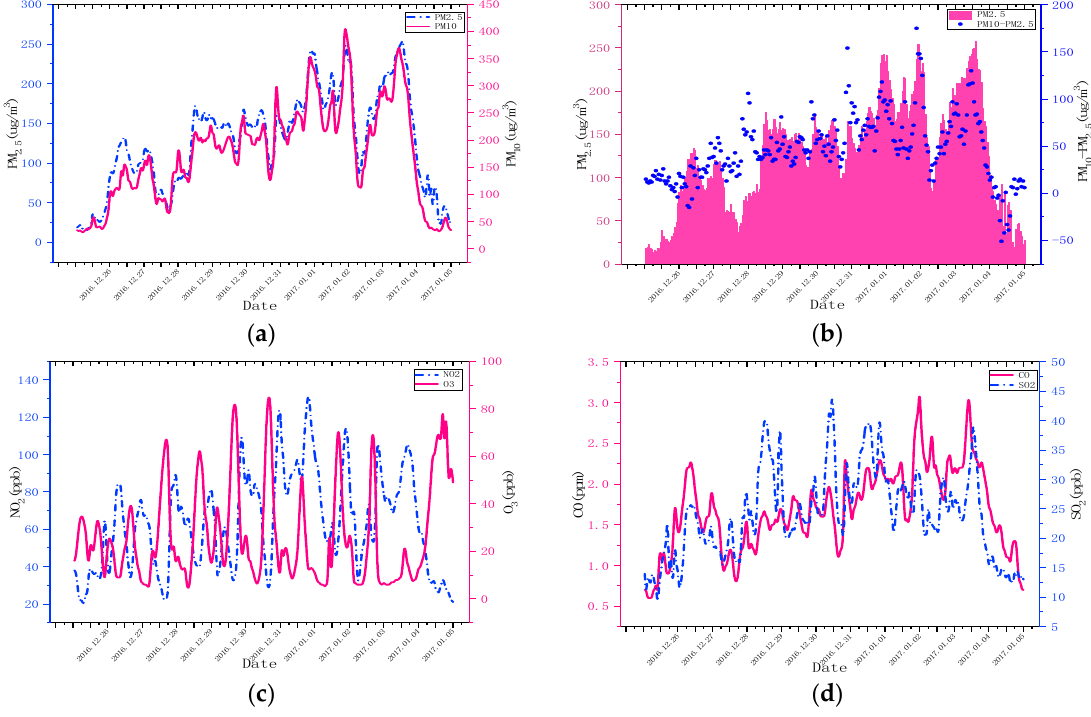
Figure 4. Concentrations of PM 2.5 , PM 10 , SO 2 , CO, and NO 2 in Huainan.